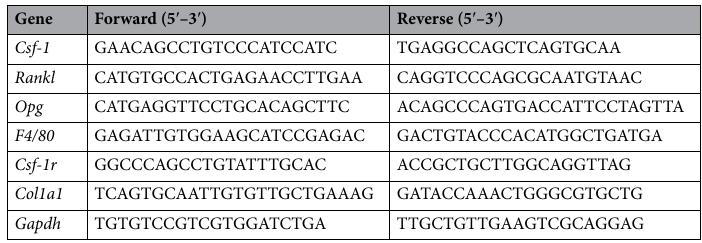
Table 1. Primers used for Real-time